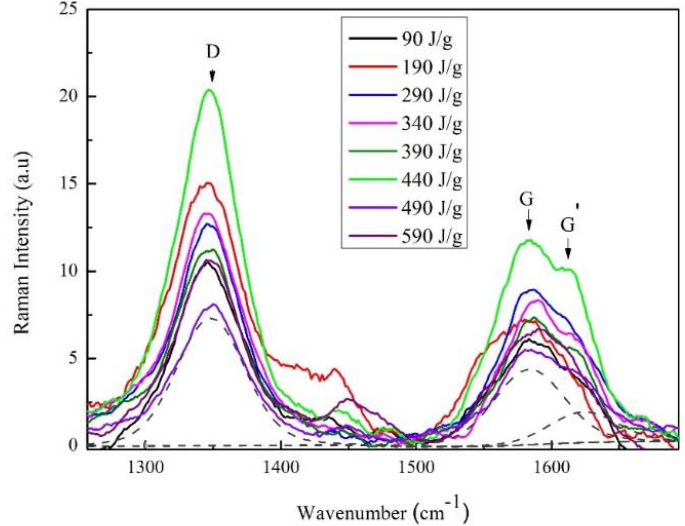
Figure 1. Raman spectra of Multi ‐ Wall Carbon Nanotubes (MWCNTs)/TX ‐ 100/H 2 O at different energies of sonication; and the dotted lines show the deconvolution of the D, G and G’ bands.